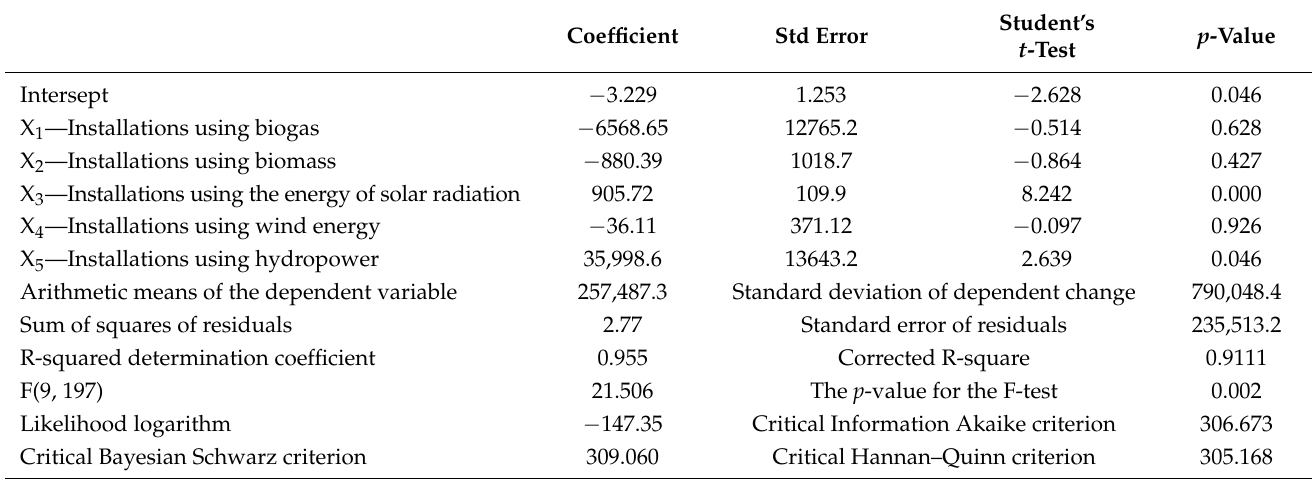
Table 3. Results of the multiple regression analysis investigating the relationship between the depen- dent variable Y 1 (electricity production from renewable energy sources) and the explanatory variables.